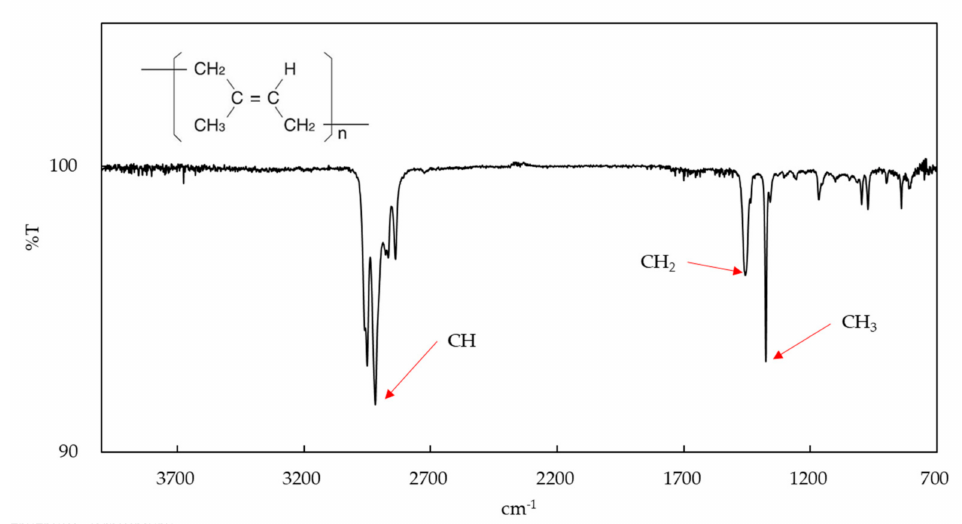
Figure 4. X-ray di ff raction pattern of EE.